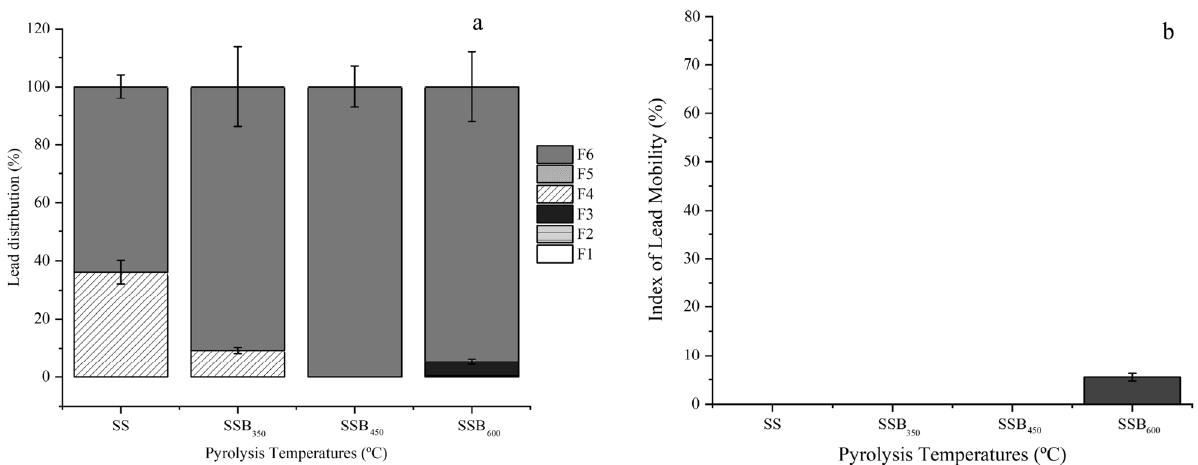
Figure 7. Lead fraction distribution ( a ) and mobility index ( b ) of sewage sludge biochar produced at 350 (SSB 350 ), 450 (SSB 450 ) and 600 (SSB 600